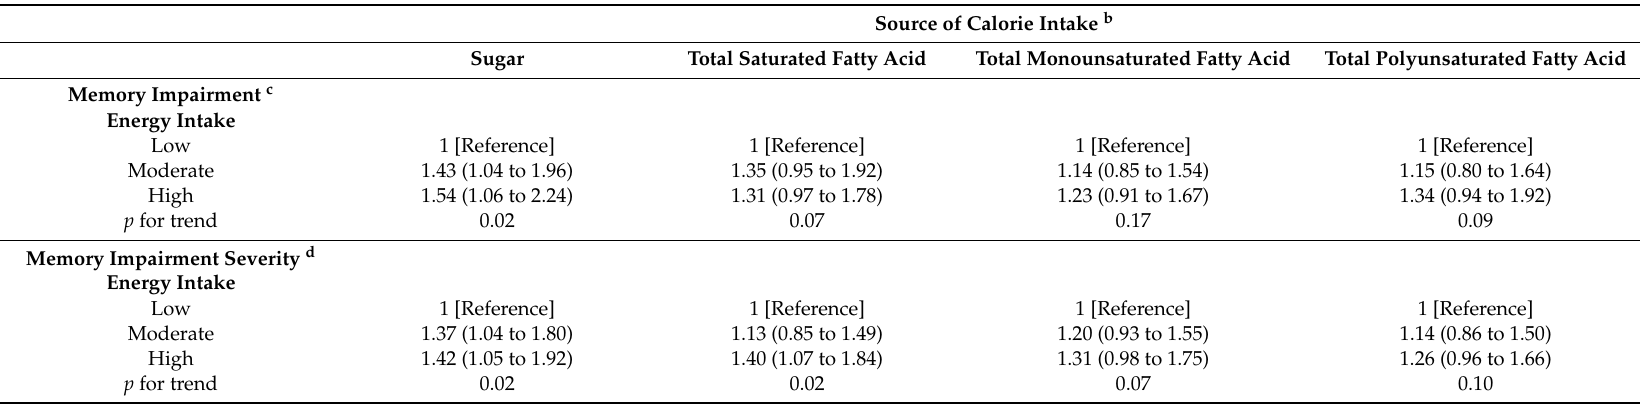
Table 4. Multivariable-adjusted Association of Source-Specific Energy Intake and Memory Impairment Among US Adults ≥ 60 years, NHANES 2011–2014 a